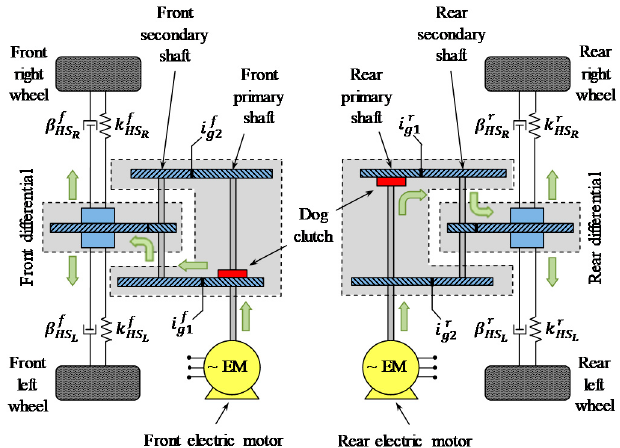
Figure 4. Simplified conceptual schematic of the 2-speed 4WD EV (L4).